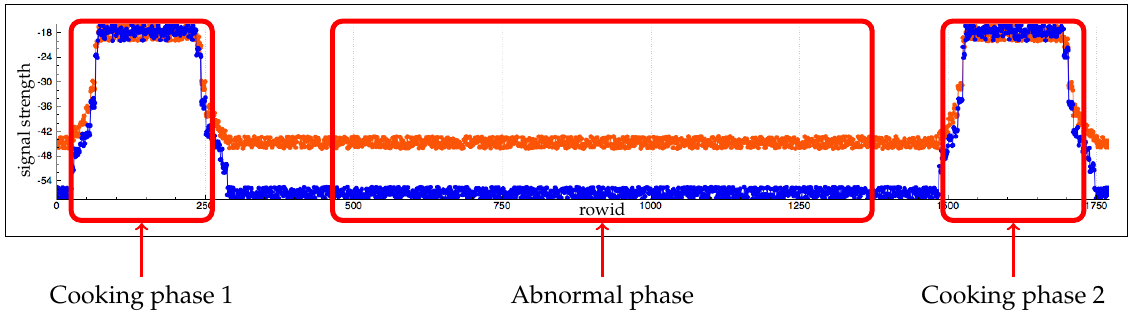
Figure 23. Sample of the received signal strength indication (RSSI) of antennas RFID2 and RFID3.